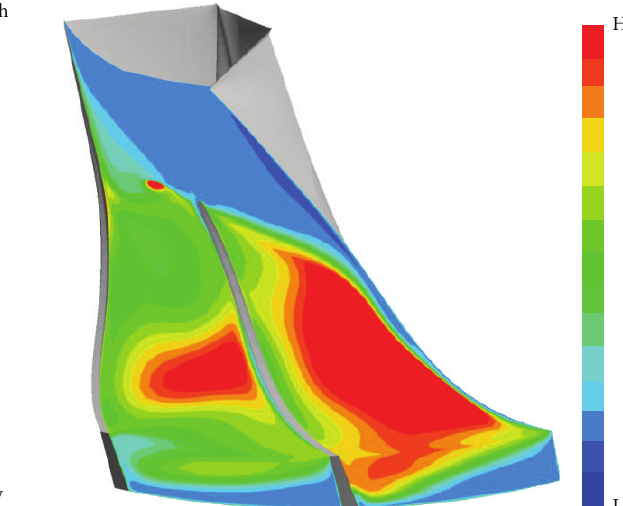
Figure 19: 𝑏/𝑏 2 = 0.50